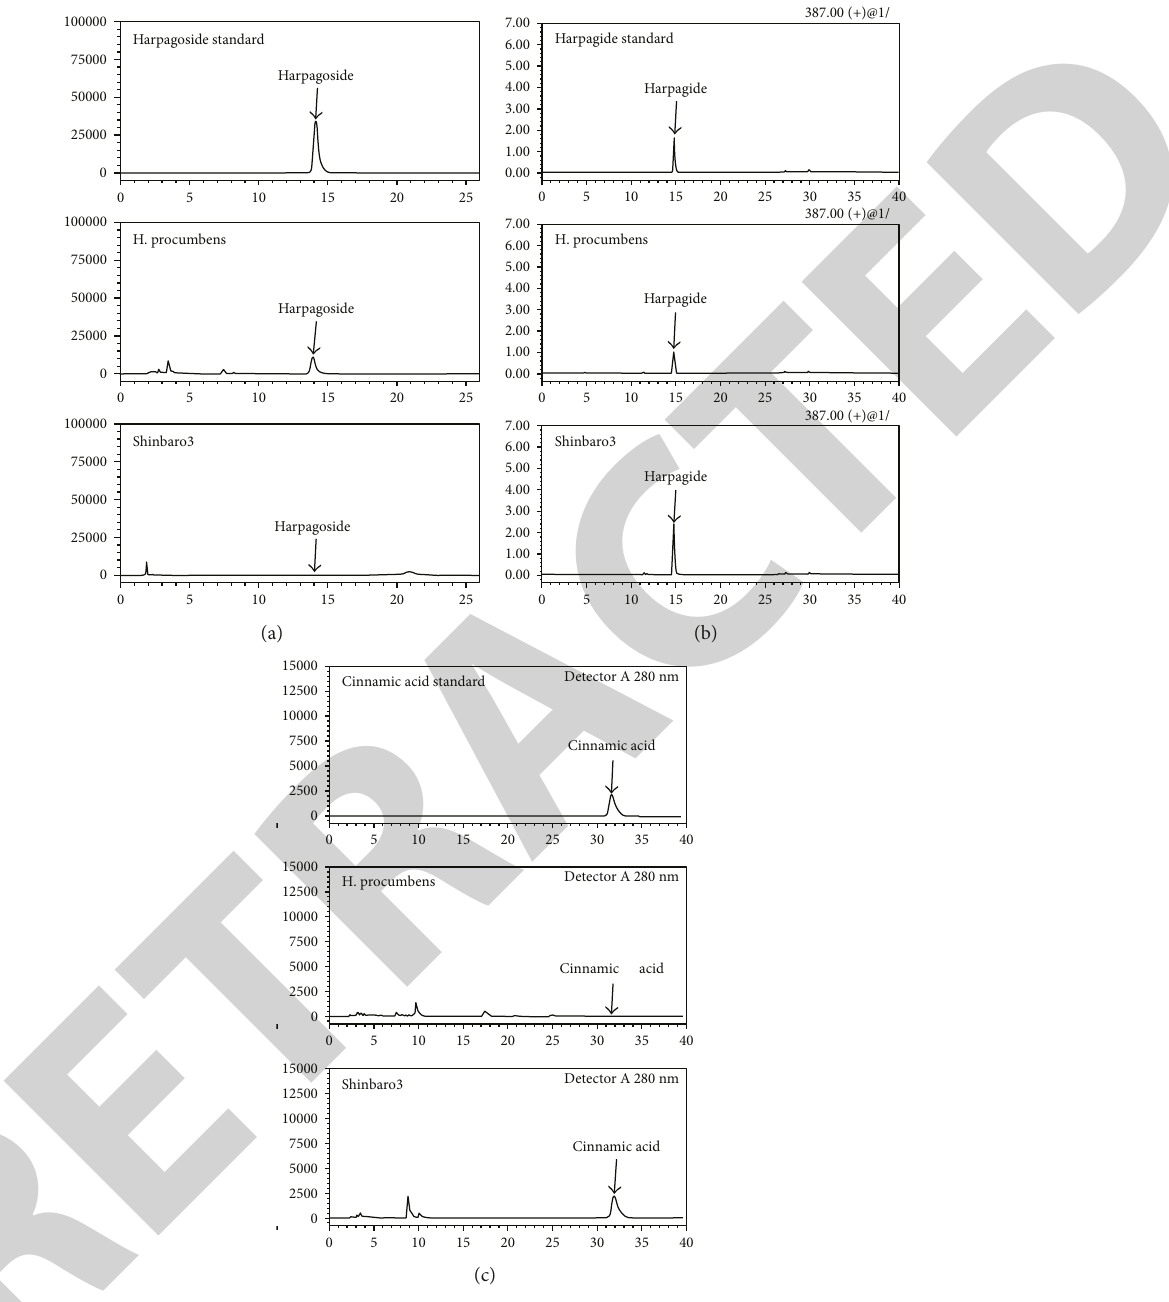
Figure 1: HPLC chromatograms of H. procumbens extract and Shinbaro3. HPLC chromatogram peaks corresponding to (a) harpagoside, (b) harpagide, and (c) cinnamic acid in H. procumbens extract (before hydrolysis) and alkaline-hydrolysed Shinbaro3 (after Table 1: Quantities of compounds present in H. procumbens extract and Shinbaro3.